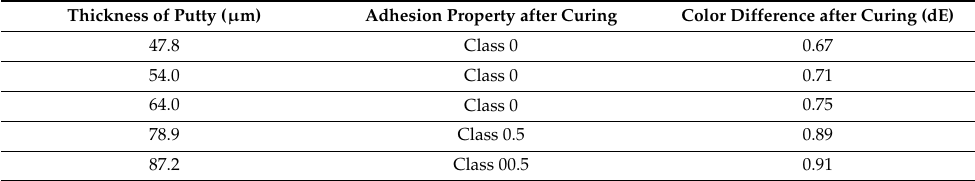
Table 5. Adhesion property and color differences of the epoxy-putty-treated